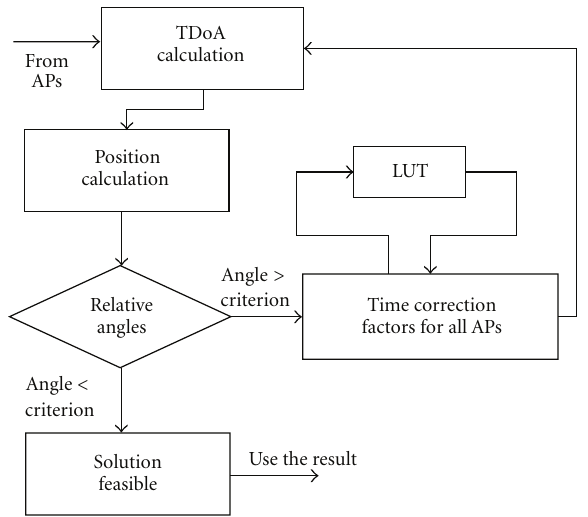
Figure 10: Schematic representation of the AIR influence correc- tion algorithm.